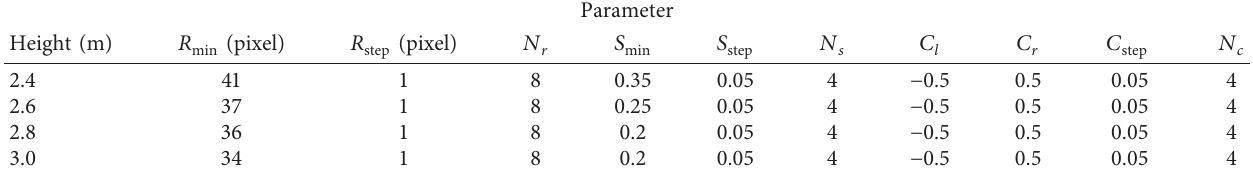
Table 4: The prior transformation parameters for the outer idler outer edge detection.